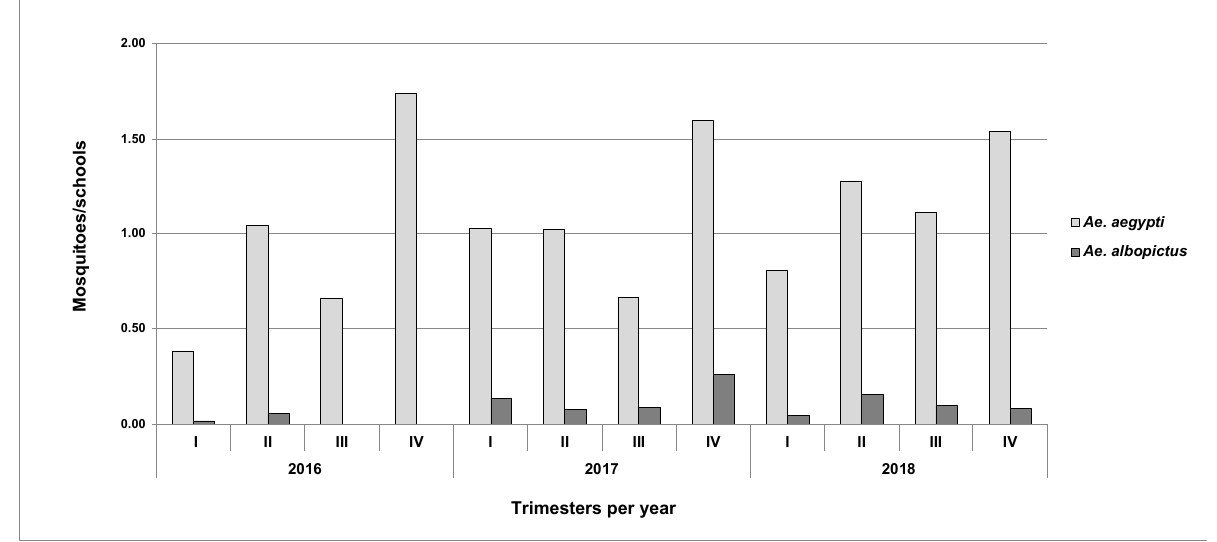
Figure 2. Average number of Aedes spp. mosquitoes captured in schools in Medellín between 2016 and 2018.